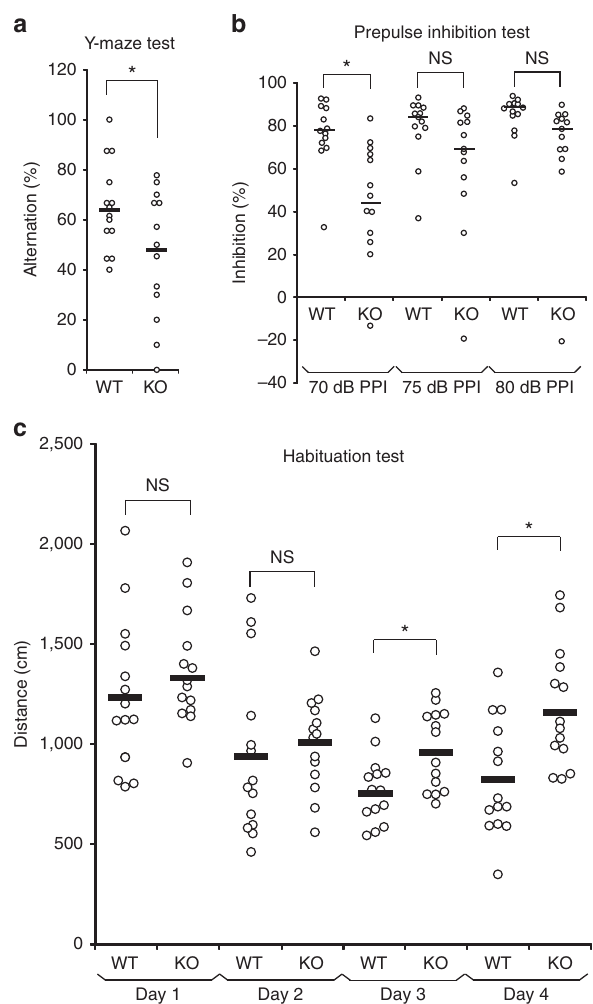
Figure 3 | Behavioural abnormalities in ARHGAP33 KO mice. ( a ) Impaired spontaneous alternations of ARHGAP33 KO mice during the Y-maze test (WT, n ¼ 14, KO, n ¼ 13, F 1,25 ¼ 5.18, P ¼ 0.031, one-way ANOVA). * P o 0.05. Bars show mean values. ( b ) Impaired PPI of ARHGAP33 KO mice (each n ¼ 13, P ¼ 0.046, Friedman test followed by Scheffe tests). * P o 0.05. NS, not significant. Bars show median values. ( c ) Impaired open field habituation of ARHGAP33 KO mice during the openfield habituation test (each n ¼ 14, genotype effect, F 1,26 ¼ 5.08, P ¼ 0.033, two-way ANOVA with repeated measures; day 3, P ¼ 1.3 (cid:2) 10 (cid:3) 4 , day 4, P ¼ 7.0 (cid:2) 10 (cid:3) 4 , Tukey–Kramer post hoc tests). * P o 0.05. NS, not significant. Bars show mean